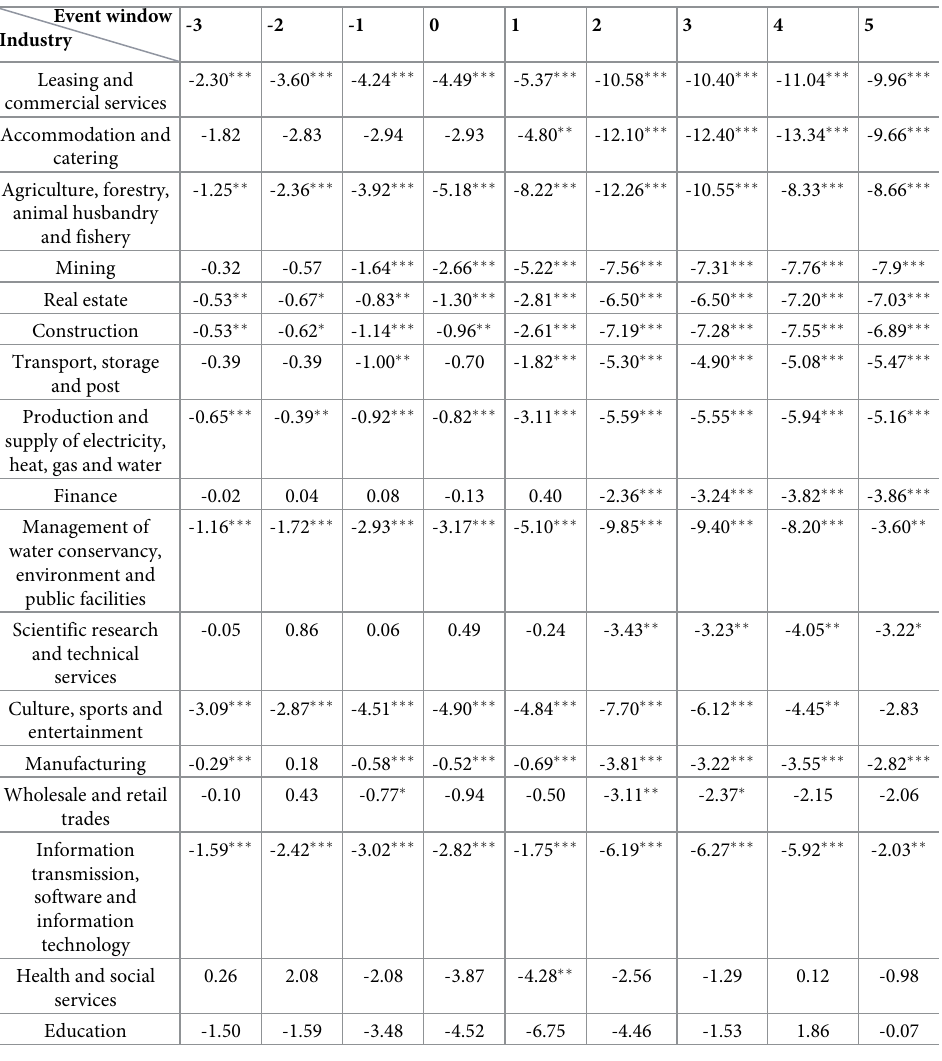
Table 2. Industry-specific CAARs at 1-digit level over the 9-day event